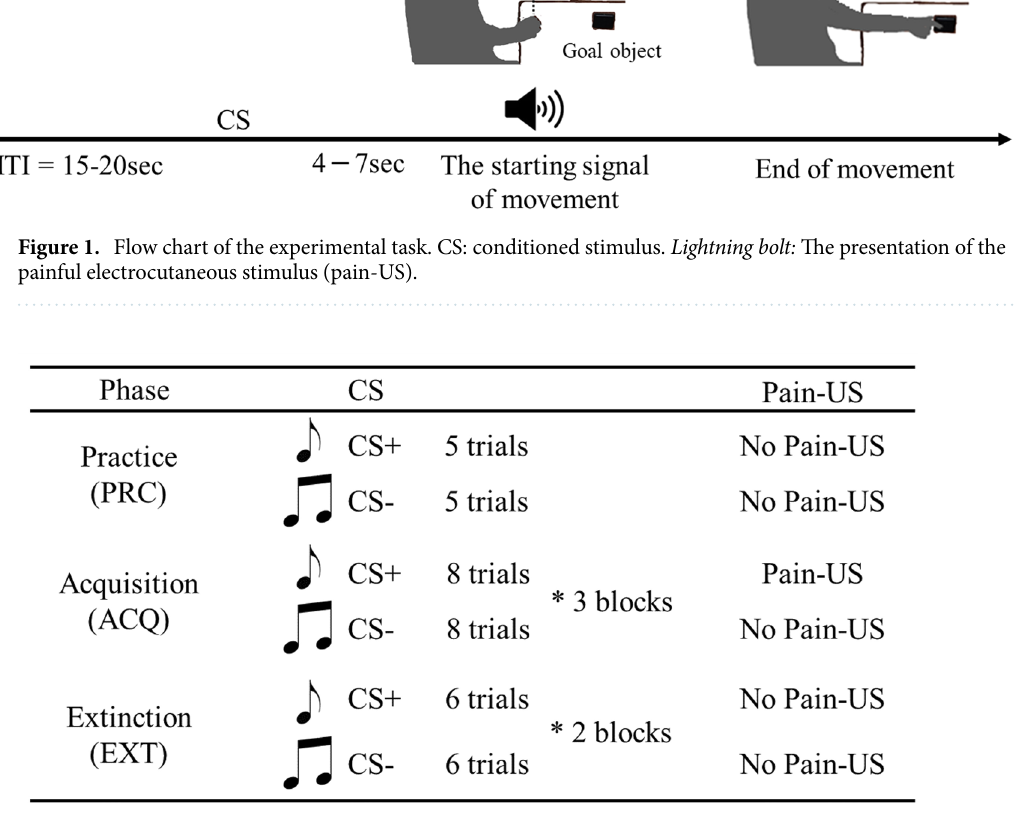
Figure 2. Study design. CS+ : The movement that is paired with the pain-US only during the acquisition phase. CS− : The movement that is never paired with the